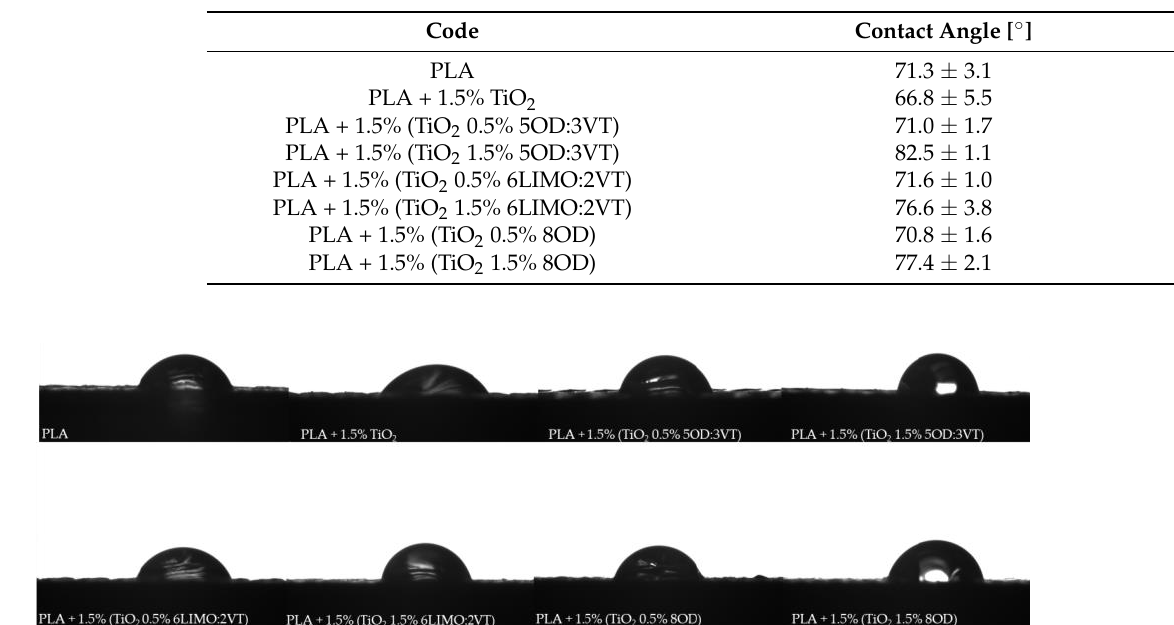
Table 6. Water contact angle of composites [ ◦ ].